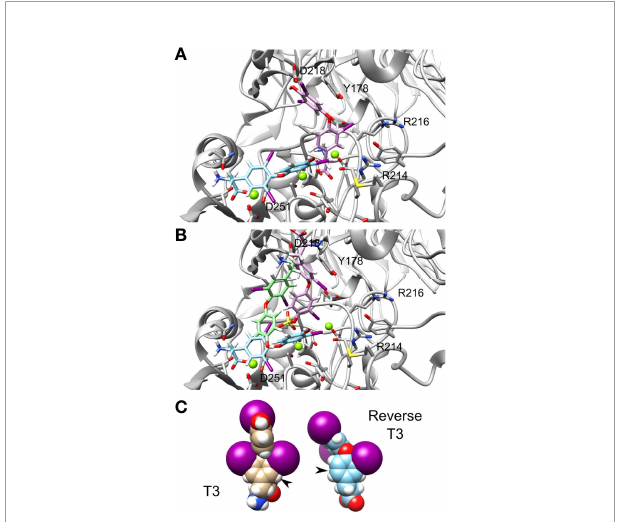
FIGURE 5 | T3 and reverse T3 docked structures. Integrin ’ s binding site backbone (ribbons) and side chains (sticks) are colored gray with oxygen atoms in red and nitrogen in blue. (A) The docked structure of T3 (ZINC000003830999) and reverse T3 (ZINC000004097417) in the a v b 3 binding site. Atom coloring scheme is as follows: T3 carbon (cyan), reverse T3 carbon (pink), iodine (purple), oxygen (red), nitrogen (blue), and hydrogen (white). (B) Docked structures of T3, T3S (pink), and T3AM (green). Carbon colors are: T3 (cyan), T3S (pink), and T3AM (green). (C) Space fi lling model of T3 and reverse